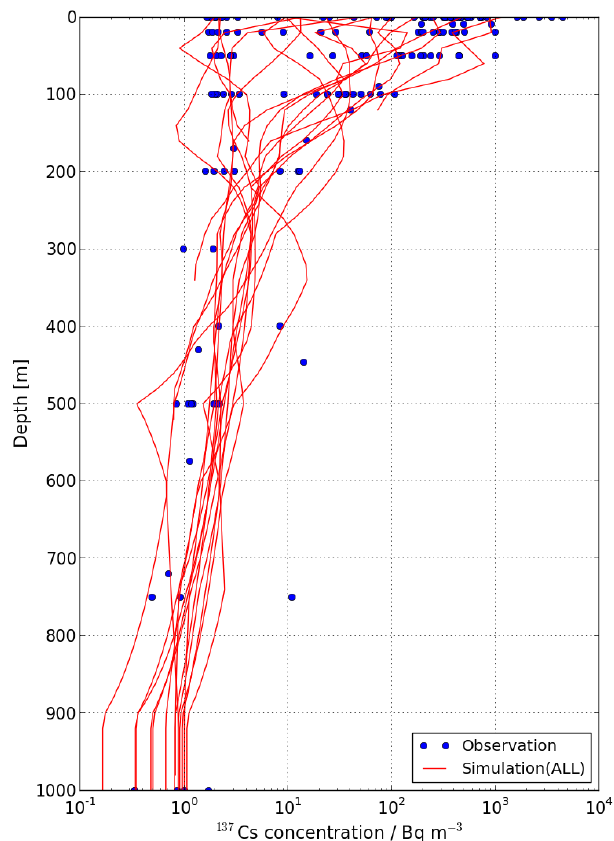
Fig. 10. Measured and simulated (ALL scenario) vertical profiles of 137 Cs activities (Bqm − 3 ) in the area of the KOK cruise (Buesseler et al.,